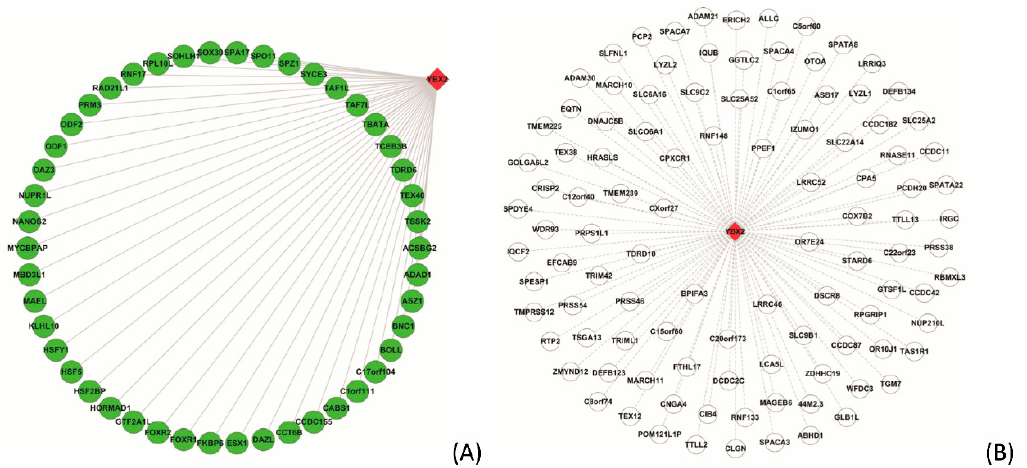
Figure 5. The validated and not validated PPIs related to the protein YBX2. The PPIs are extracted via the evidence of co-expression in STRING. ( A ) illustrates the PPIs that are validated by the proposed Neglog method. Only the PPIs whose partners are subcellularly colocalized and get involved common biological processes are illustrated for clarity; ( B ) illustrates the PPIs that are NOT validated, and only the partners that are not subcellularly co-localized and not involved in common biological processes are illustrated for clarity. The nodes in green connected with solid lines indicate the partners that interact with the protein YBX2, while the nodes in white connected with long dash lines indicate the proteins that do not interact or functionally interact with the protein